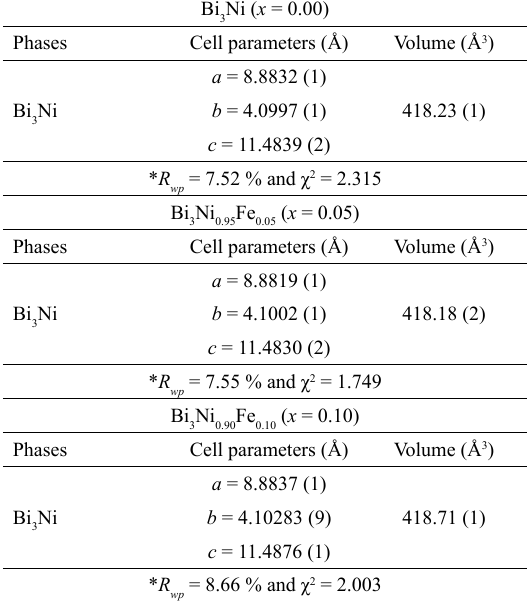
Figure 1. XRD patterns taken at room temperature of polycrystalline Bi Ni Fe sample. 3 1-x x Table 1. Lattice parameters a , b , c and unit cell volume V for polycrystalline Bi Ni Fe samples. Numbers in parentheses indicate 3 1-x x the standard